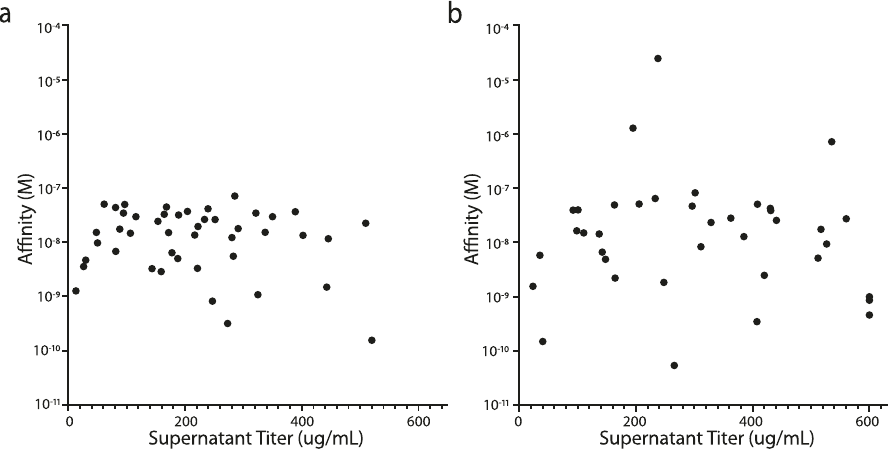
Fig. 7 Af fi nities and expression levels of clones selected against human CD73. a expression level and af fi nity of human-speci fi c IgG clones b expression level and af fi nity of IgG antibodies selected against CD73 recognizing both the human and the murine